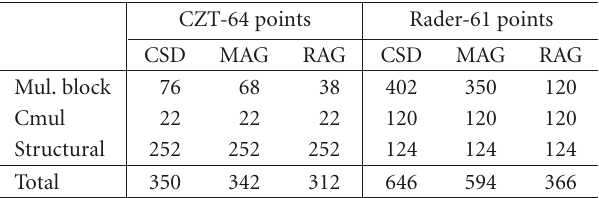
Table 3: Total required adders for complex DFTs.